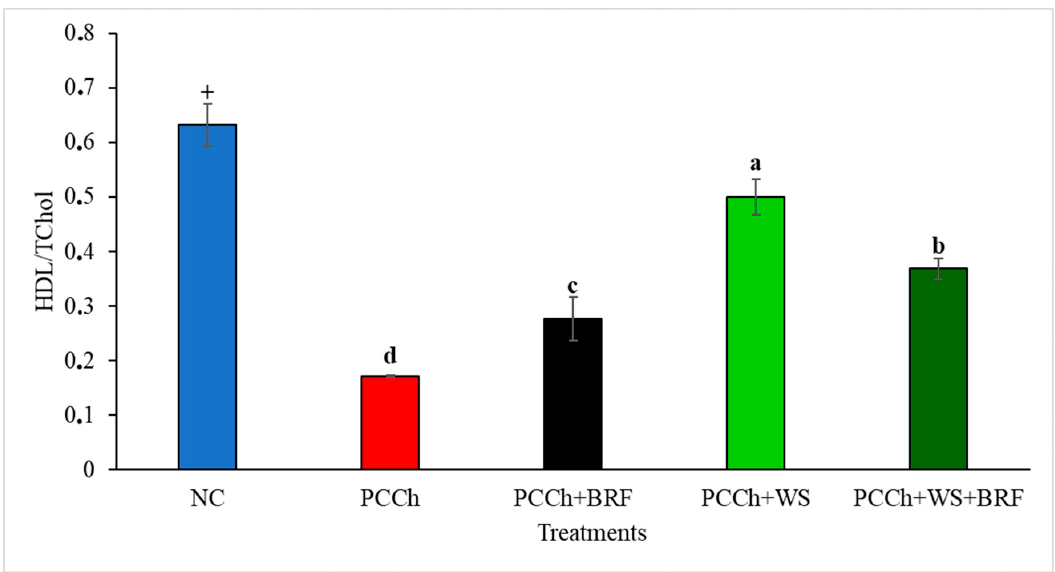
Figure 4. Plasma high-density lipoprotein (HDL) cholesterol/total cholesterol ratio in experimental groups. NC: AIN-76A diet. PCCh: positive control (0.5% cholesterol, 0.05 cholic acid, 3% butter). BRF: black rice fraction. PCCh + BRF: positive control with black rice fraction. PCCh + WS: positive control with wood sterols. PCCh + WS + BRF: positive control with wood sterols and black rice fraction. Bars represent means ± SEM ( n = 8). The + symbol signifies a significant difference ( p < 0.05) between the negative cholesterol (NC) and positive control groups (PCCh). Bars with different superscript letters (a, b, c, and d) are significantly different ( p ≤ 0.05).